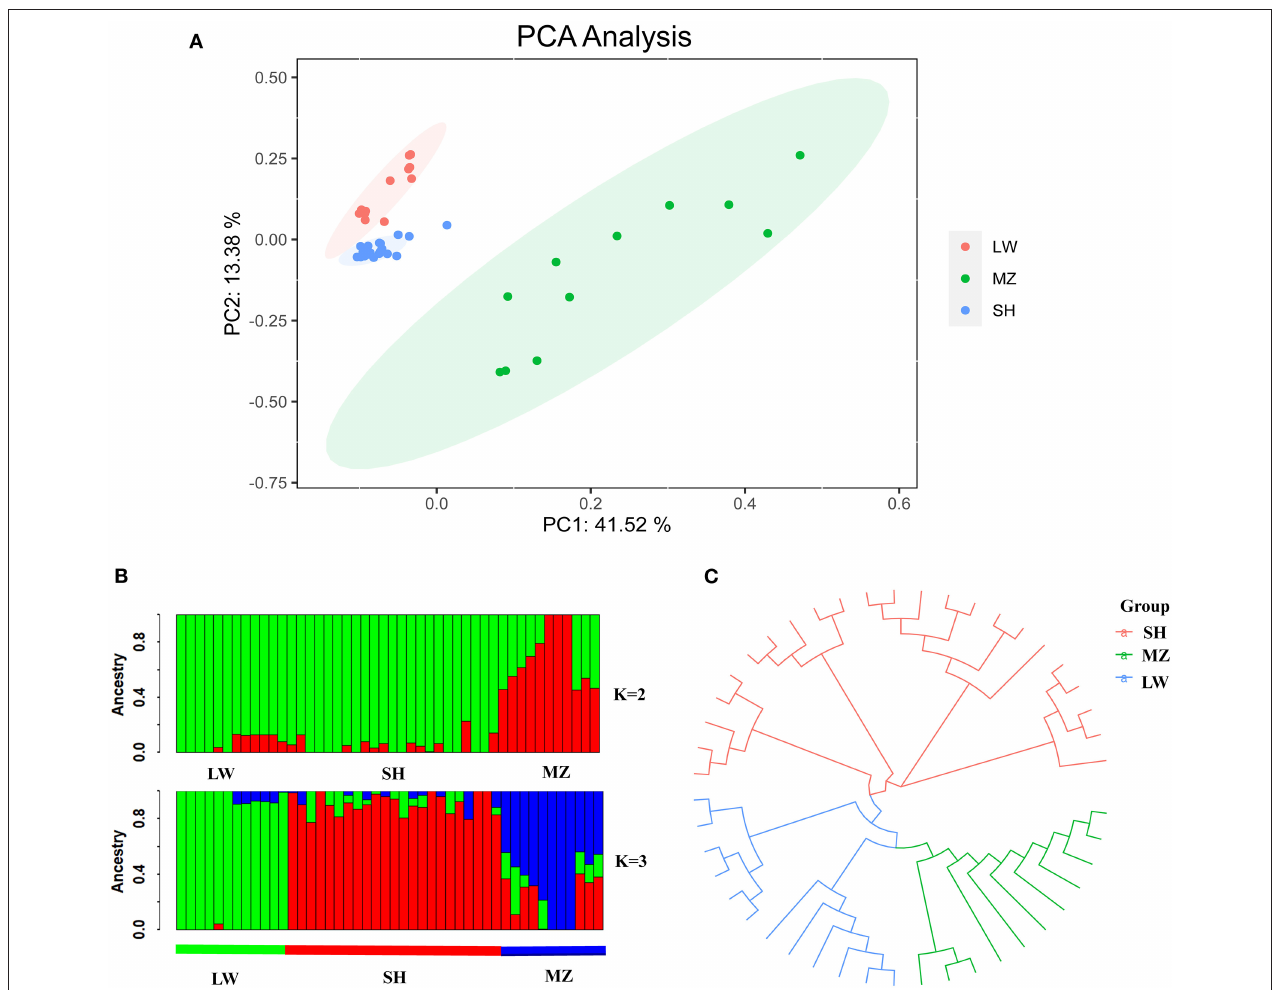
FIGURE 2 | (A) PCA plot of LW, MZ, and SH pigs. Red, green, and blue represent LW, MZ, and SH pigs, respectively. (B) Diagram of genetic structure analysis, the K value represents the number of the hypothetical ancestor. When the ancestral population number K = 2, there are obvious differences between LW and MZ pigs, while the information of SH pigs is covered by LW pigs, green and red represent LW and MZ pigs, respectively. When K = 3, the three pig breeds are well separated. Green, red, and blue represent LW, SH, and MZ pigs, respectively. (C) Evolutionary tree diagram of LW, SH, and MZ pigs. The location of SH pigs is closer to the root, moreover, the genetic distance between SH and LW pigs is less than SH and MZ